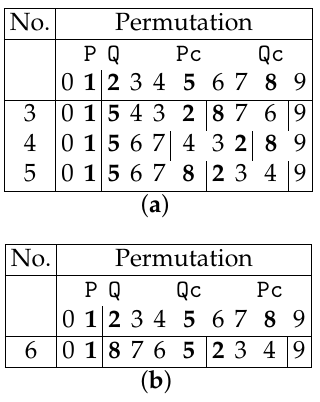
Table 4. List of possible 3-opt operations based on a 10-points example: ( a ) circular order PQ → Pc → Qc ; ( b ) circular order PQ → Qc → Pc